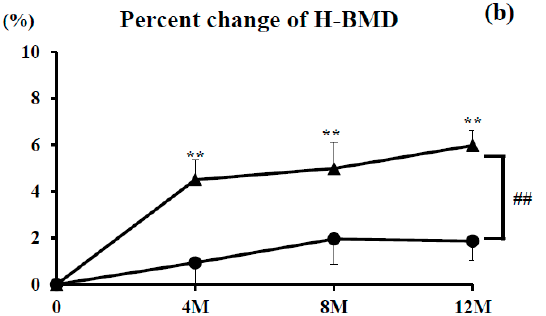
Figure 3. Percent changes in lumbar bone mineral density (L-BMD) ( a ) and bilateral total hip BMD (H-BMD) ( b ) over the 12-month study period. Closed circles show the denosumab monotherapy group and closed triangles show the combination group. Double asterisks (**) denote significant differences ( p < 0.01) at each time point compared with pretreatment in the denosumab monotherapy or combination groups. Double hashtags (##) show significant differences ( p < 0.01) between the denosumab monotherapy and combination groups at each time point.